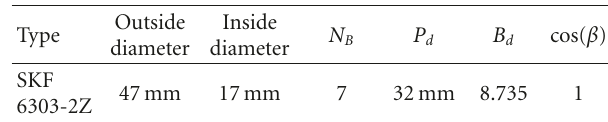
Table 1: Bearing